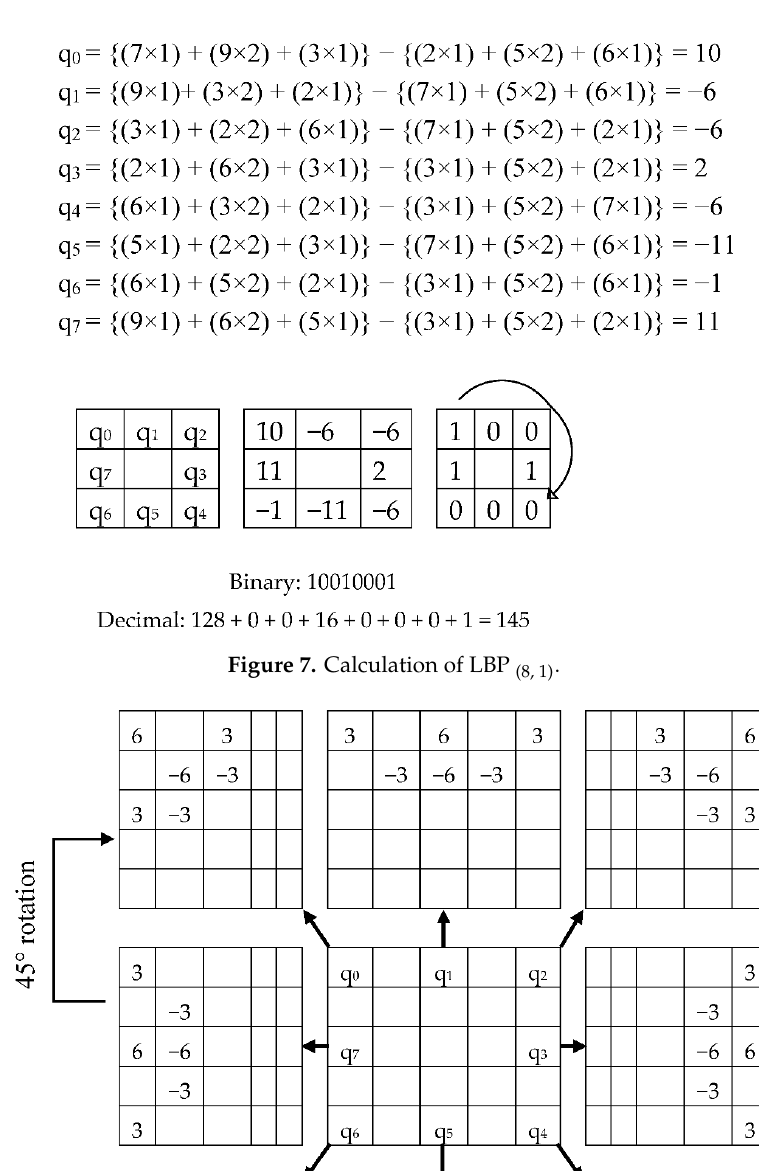
Figure 9. Calculation of LBP (8, 2) .